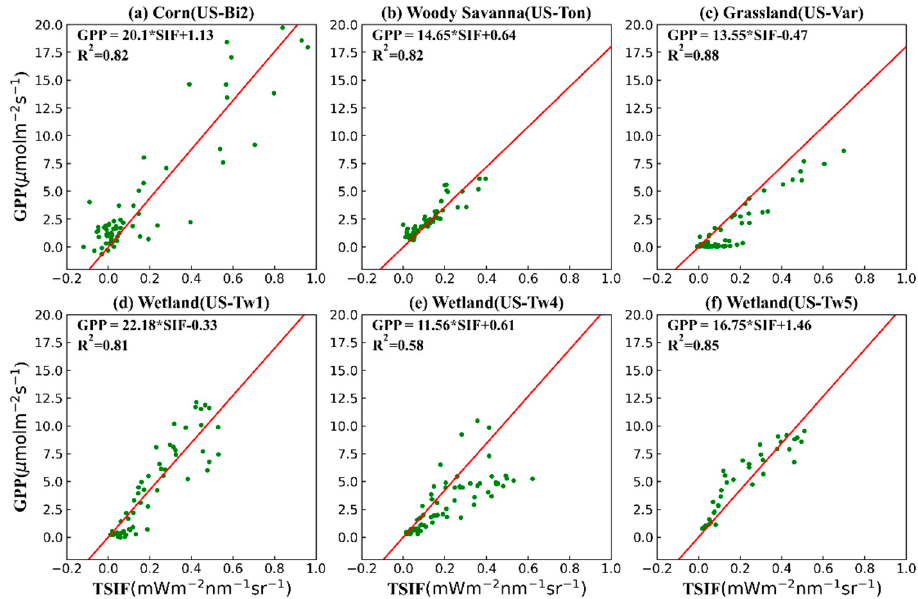
Figure 13. Scatterplots of GPP and TSIF from six eddy covariance sites of AmeriFlux over four different ecosystems (corn, woody savanna, grassland, and wetland) ( a – f ). The GPP was temporally aggregated to 16-day to match the temporal resolution of TSIF. Red lines are the regression lines.